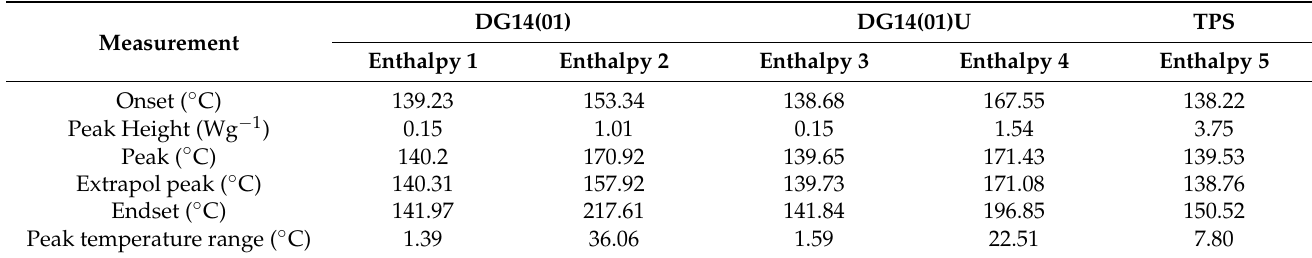
Figure 7. Plotted DSC thermographs of selected samples of TPS biocomposites. Table 4. Analysis of DSC